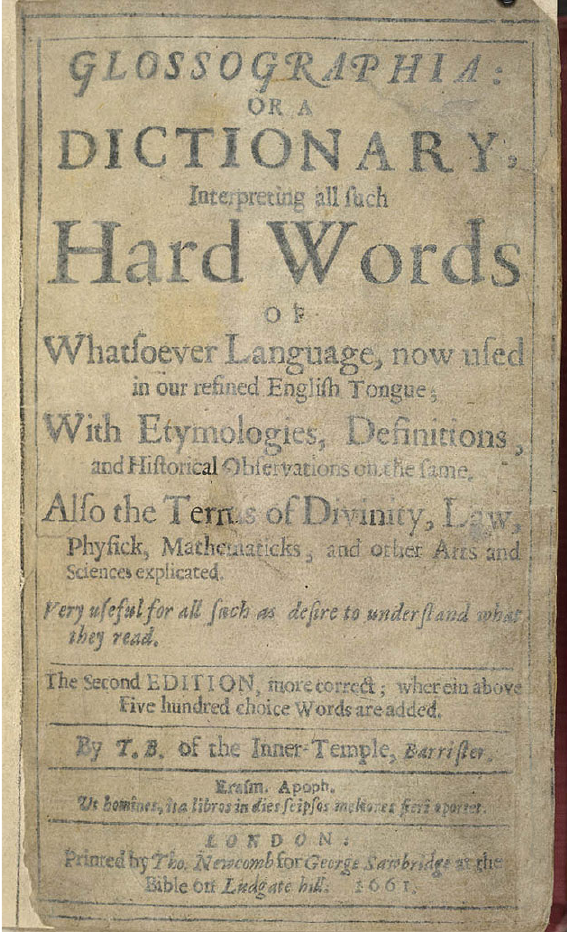
Fig. 3. Title page of Thomas Blount’s Glossographia , 1661